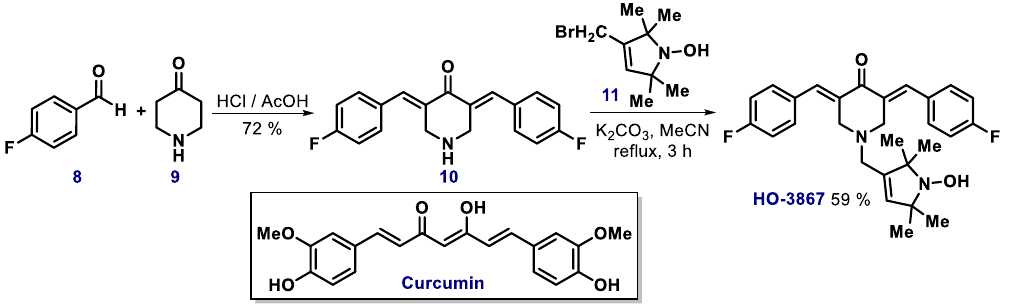
Figure 1. Structure of 3-benzoylacrylic acid derivatives reactivators of p53.